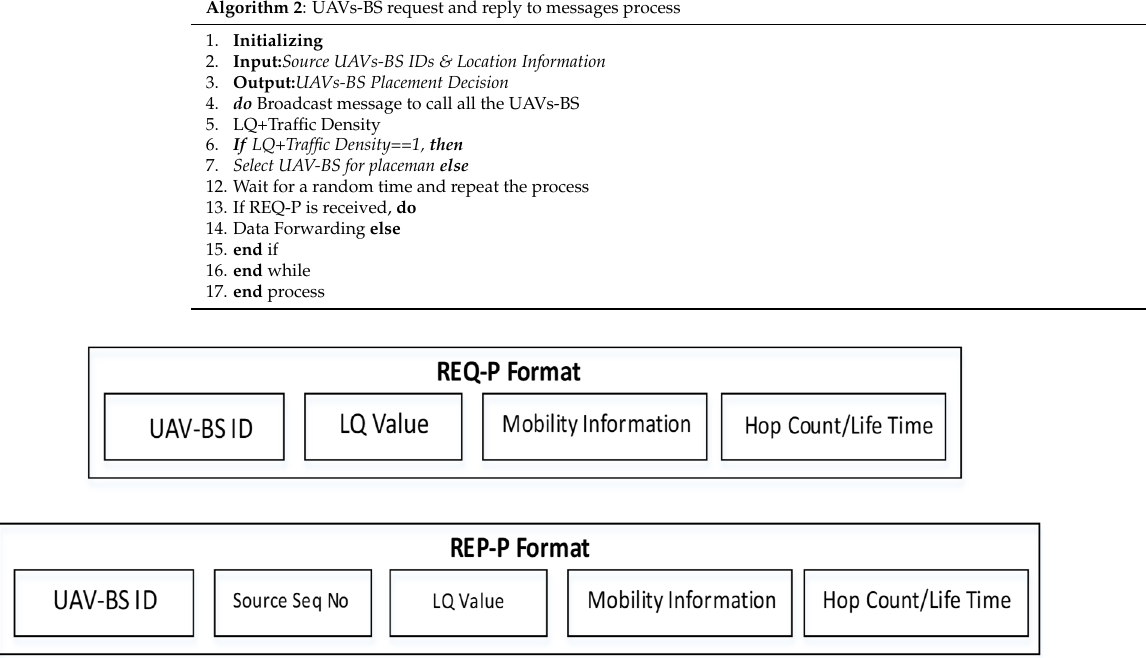
Figure 2. UAVs-BS status update process.